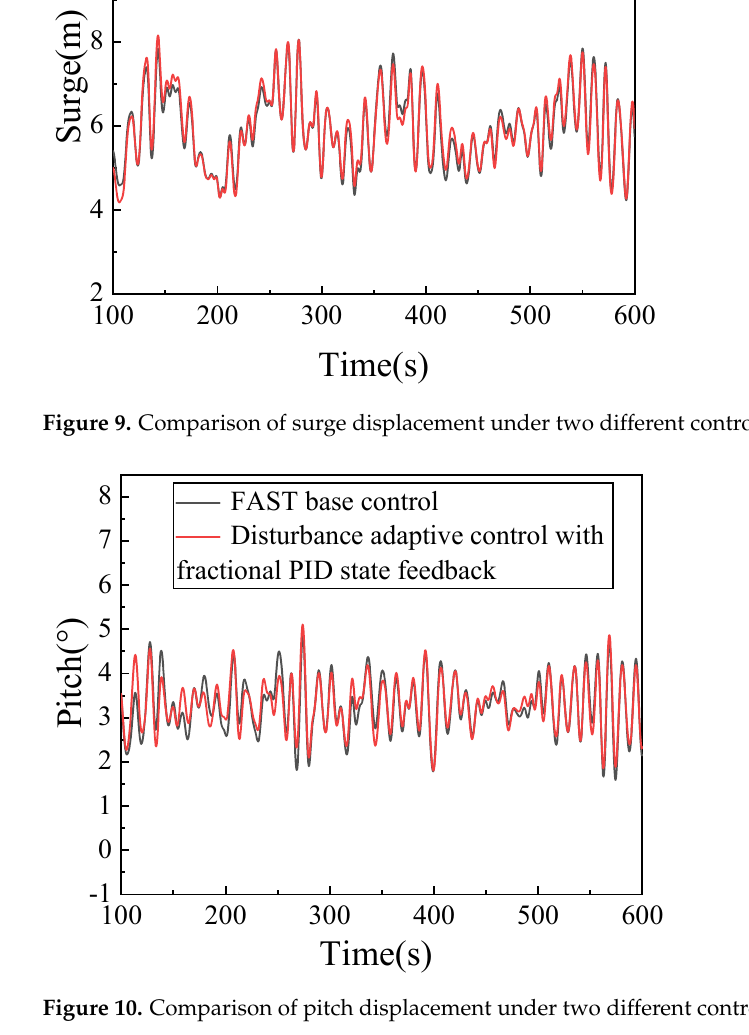
Figure 10. Comparison of pitch displacement under two different control algorithms. Table 4. Comparison of heave displacement and heave angle under two control algorithms.